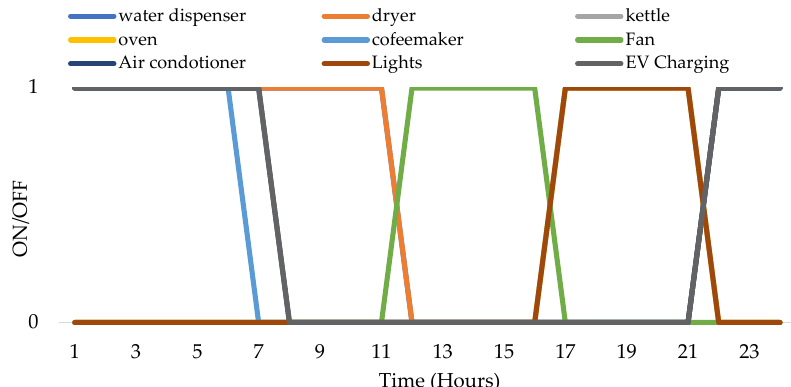
Figure 8. ON/OFF period of individual appliances for residential area.